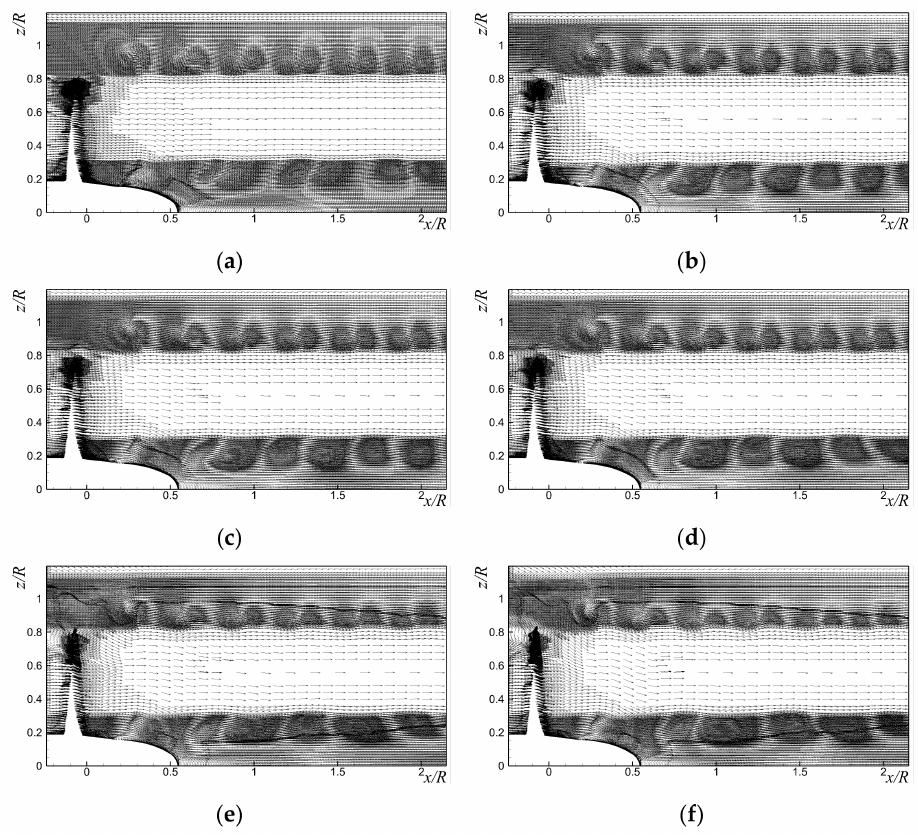
Figure 13. Instantaneous velocity vector fields in the propeller wake computed at J = 0.7 for the single propeller and for the propeller-duct arrangement with D N / D = 0.9 : ( a ) single propeller, ( b ) θ = 0 ◦ , ( c ) θ = 5 ◦ , ( d ) θ = 10 ◦ , ( e ) θ = 15 ◦ , ( f ) θ = 20 ◦